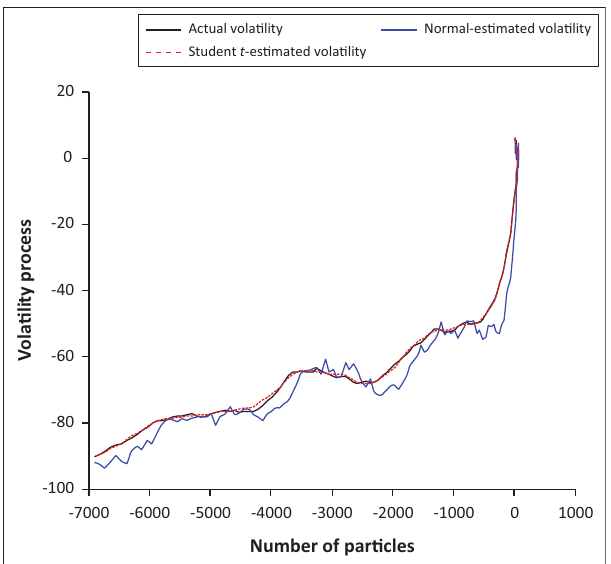
FIGURE 7: Brownian path for Oando.